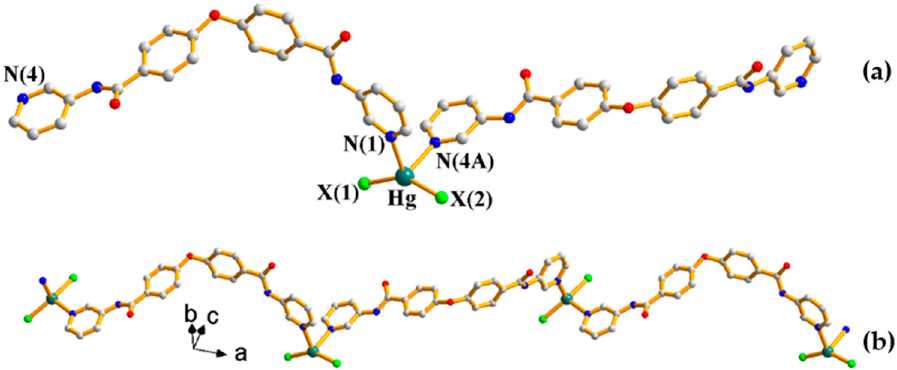
Figure 6. ( a ) A representative drawing showing the coordination environment about the Hg(II) ion for 7 – 9 . Symmetry transformations used to generate equivalent atoms: (A) x + 1, − y + 3/2, z + 1/2. ( b ) A drawing showing the 1D linear chain. Table 2. Selected bond distance (Å) and bond angles (°) for 7 (X = Cl), 8 (X = Br), and 9 (X = I).